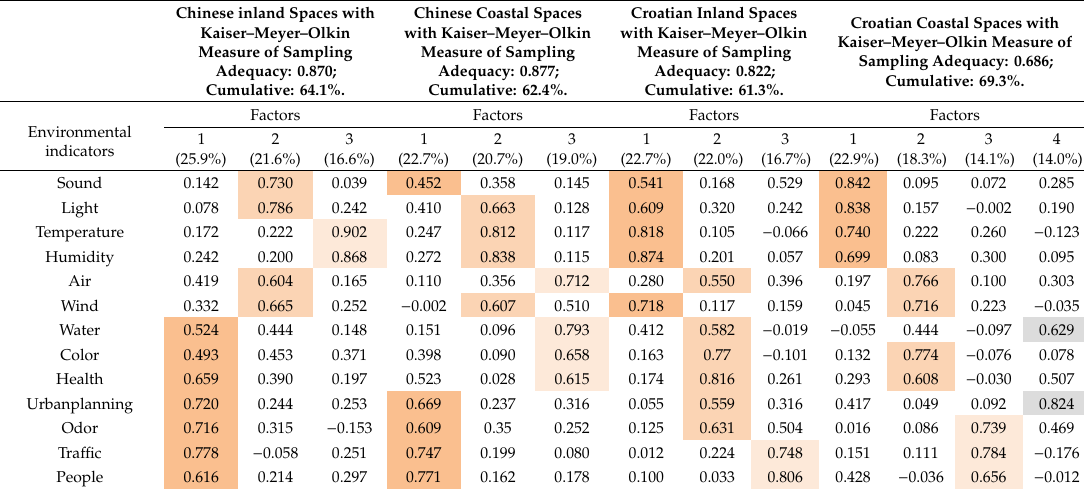
Table 5. Factor analysis of environmental indicators for inland and coastal places in China and Croatia, respectively. Croatian Inland Spaces Chinese Coastal Spaces Chinese inland Spaces with Croatian Coastal Spaces with with Kaiser–Meyer–Olkin with Kaiser–Meyer–Olkin Kaiser–Meyer–Olkin Kaiser–Meyer–Olkin Measure of Measure of Sampling Measure of Sampling Measure of Sampling Sampling Adequacy: 0.686; Adequacy: 0.822; Adequacy: 0.877; Adequacy: 0.870; Cumulative: Cumulative: 61.3%. Cumulative: 62.4%. Cumulative: 64.1%.